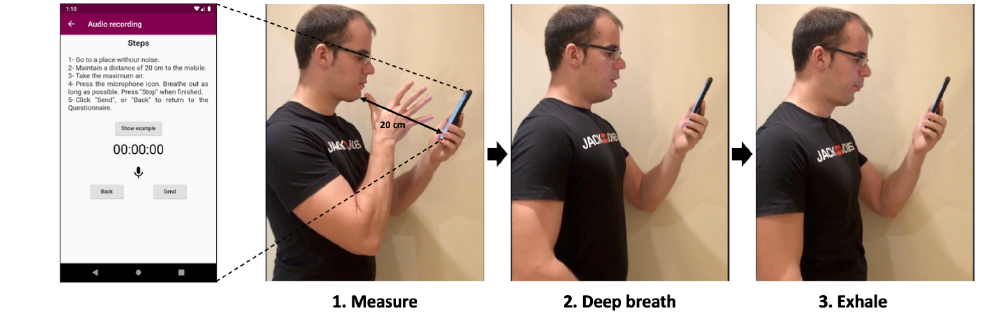
Figure 1. Data collection process. The participant opens the app, moves the phone to the indicated distance (20 cm), takes a deep breath and